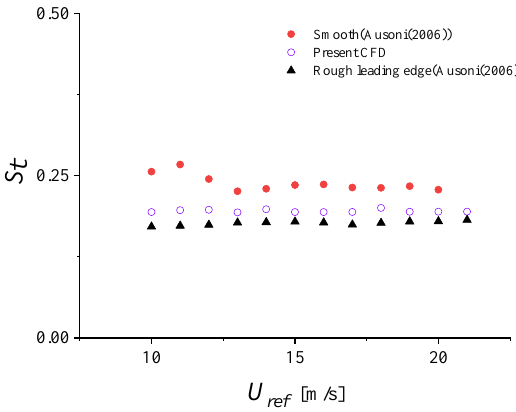
Figure 12. Strouhal number at different inflow velocities.